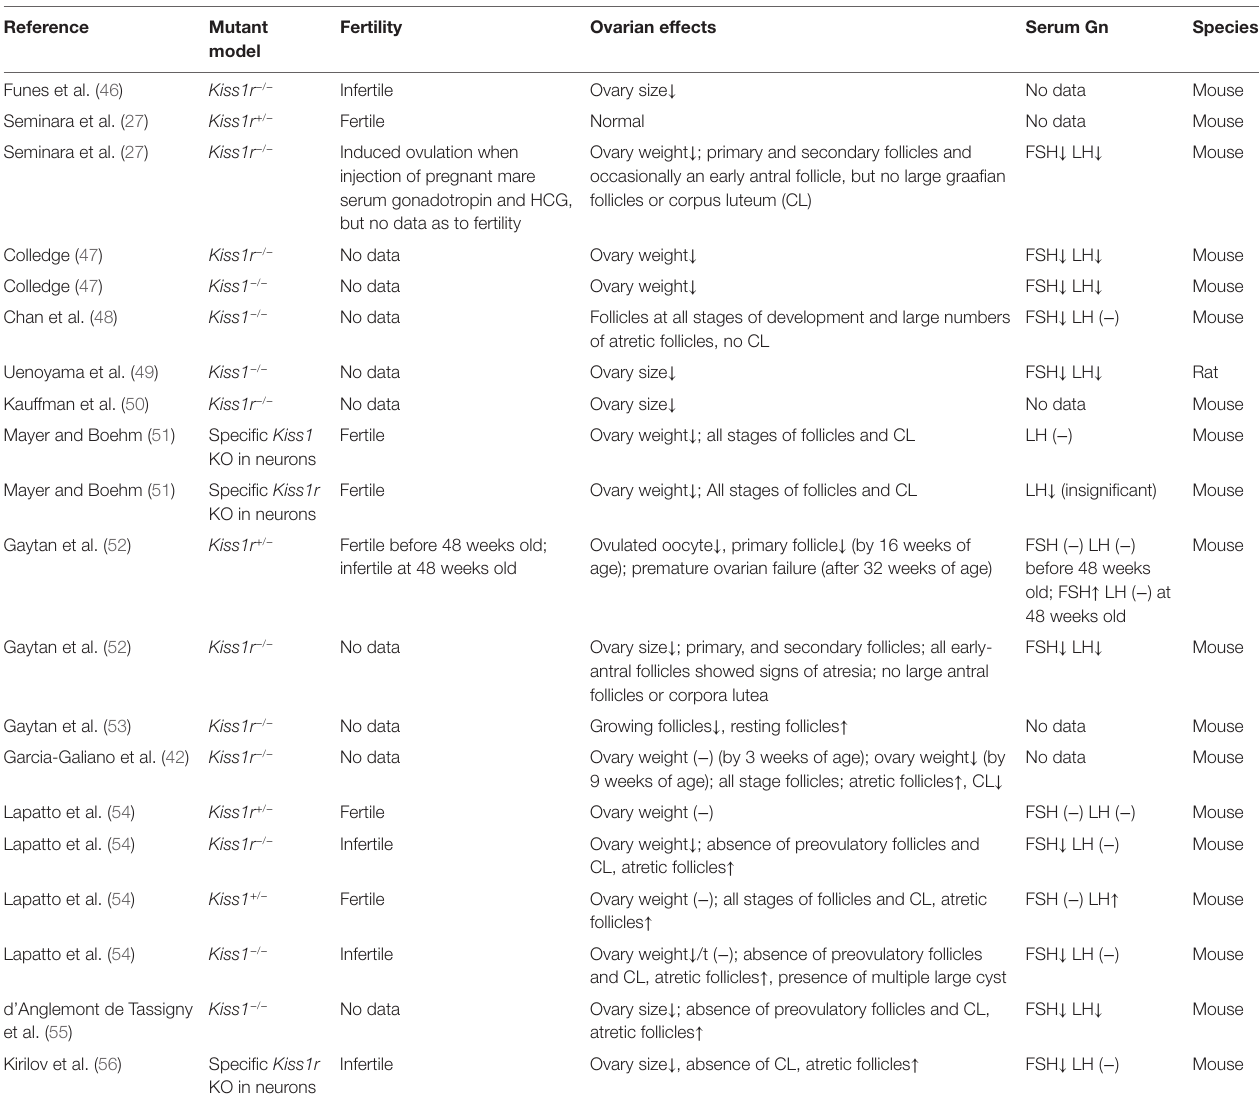
TAble 2 | Summary of the ovarian effects of Kiss1/Kiss1r in genetically modified or mutant models.